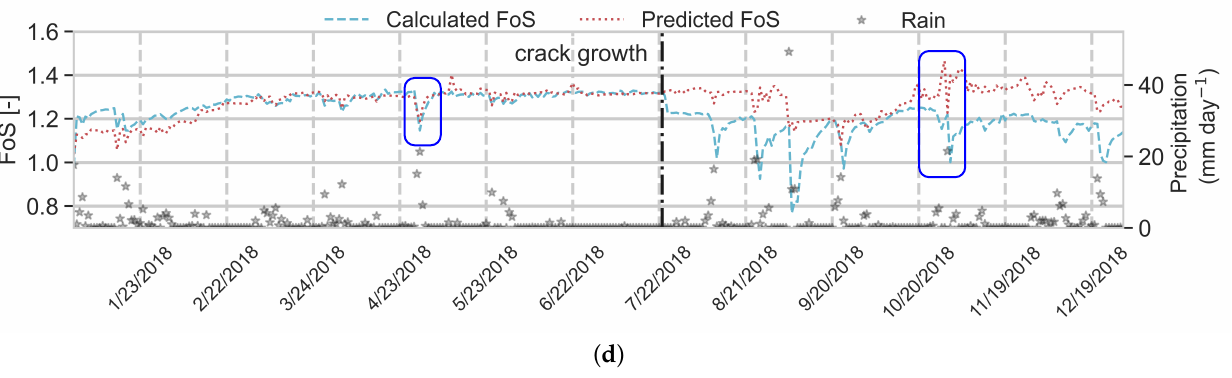
Figure 10. RF rta model performance, over ( a ) testing data set and ( b ) evaluation data set, and ( c ) time series of calculated and predicted FoS in the evaluation data set; ( d ) time series of calculated and predicted FoS in the evaluation data set using RF rta , Rain -1 d